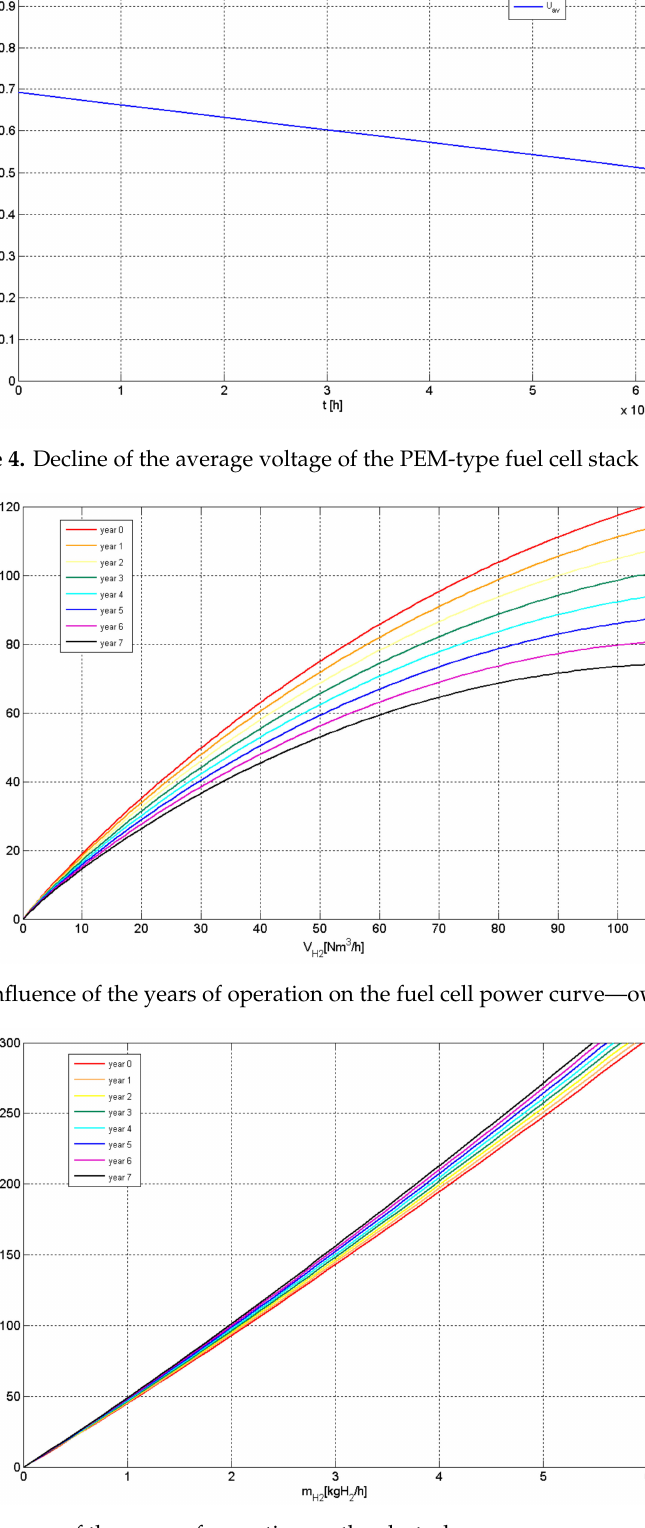
Figure 6. Influence of the years of operation on the electrolyzer power curve—own